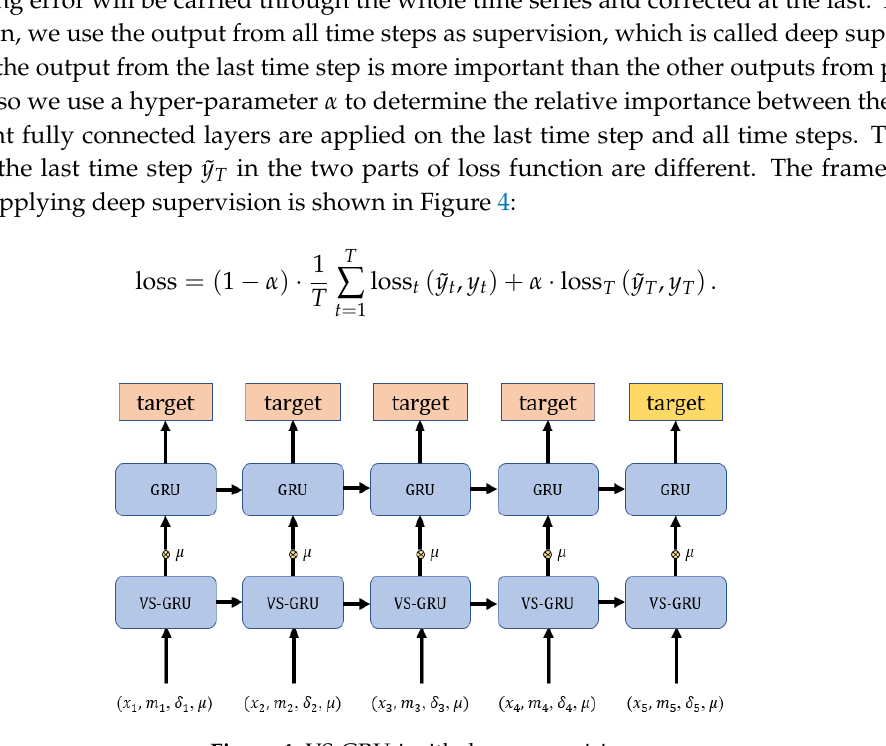
Figure 4. VS-GRU-i with deep